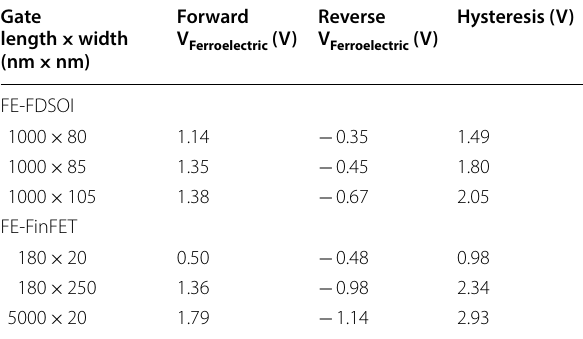
Table 2 The device dimensions of baseline FDSOI device/ FinFET vs. the hysteresis of FE-FDSOI/FE-FinFET Gate length width × (nm ×